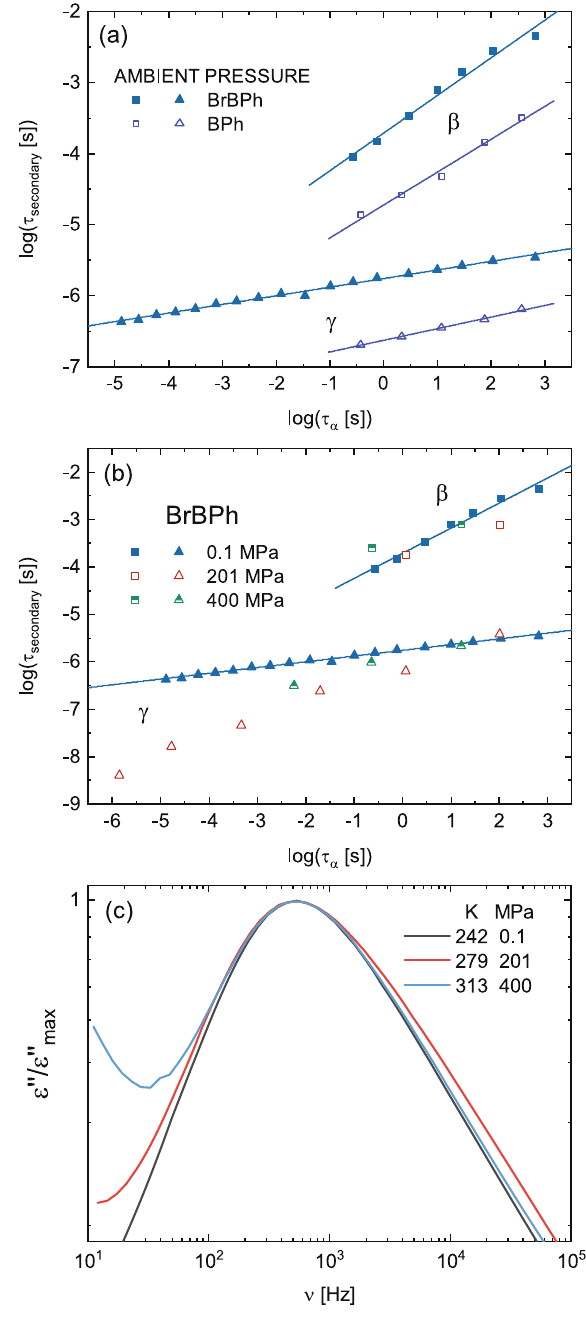
Figure 5. ( a ) Logarithmic plot of τ β and τ γ as a function of τ α (above T g ) for the ambient pressure data of BrBPh (filled markers) and BPh (open markers), and linear fits. ( b ) Same plot for BrBPh for all three measured pressures. Continuous lines are linear fits of the ambient pressure data. ( c ) Normalized isochronal plot of the loss spectra of BrBPh at three ( T , P ) pairs for which the structural relaxation frequency is roughly the same (namely, τ α ≅ 3 · 10 –4